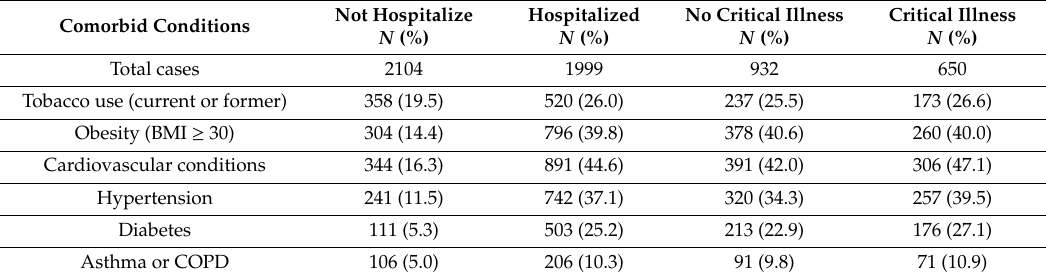
Table 2. COVID-19 hospitalization and critical illness on comorbid conditions in New York